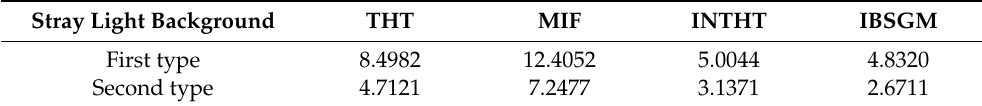
Table 1. RMSEs of the surveillance images by different algorithms. Stray Light Background THT MIF INTHT IBSGM First type